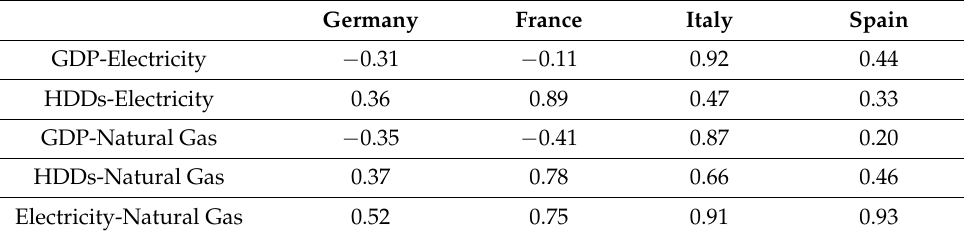
Table 3. Correlation matrix for GDP, HDDs, Electricity, and Natural Gas for the investigated countries. Source: own research. Germany France Italy Spain GDP-Electricity − 0.31 − 0.11 0.92 0.44 HDDs-Electricity 0.36 0.89 0.47 0.33 GDP-Natural Gas − 0.35 − 0.41 HDDs-Natural